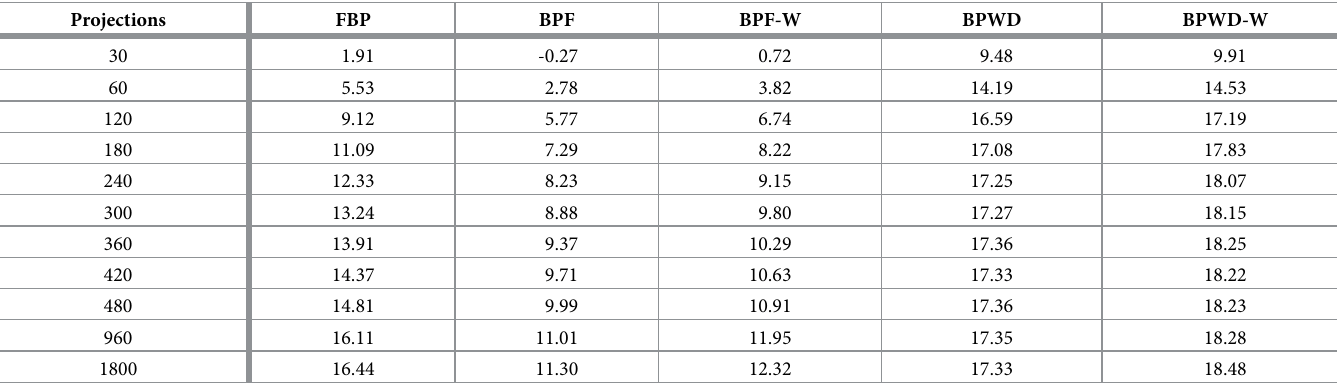
Table 2. SNR (dB) performance of different